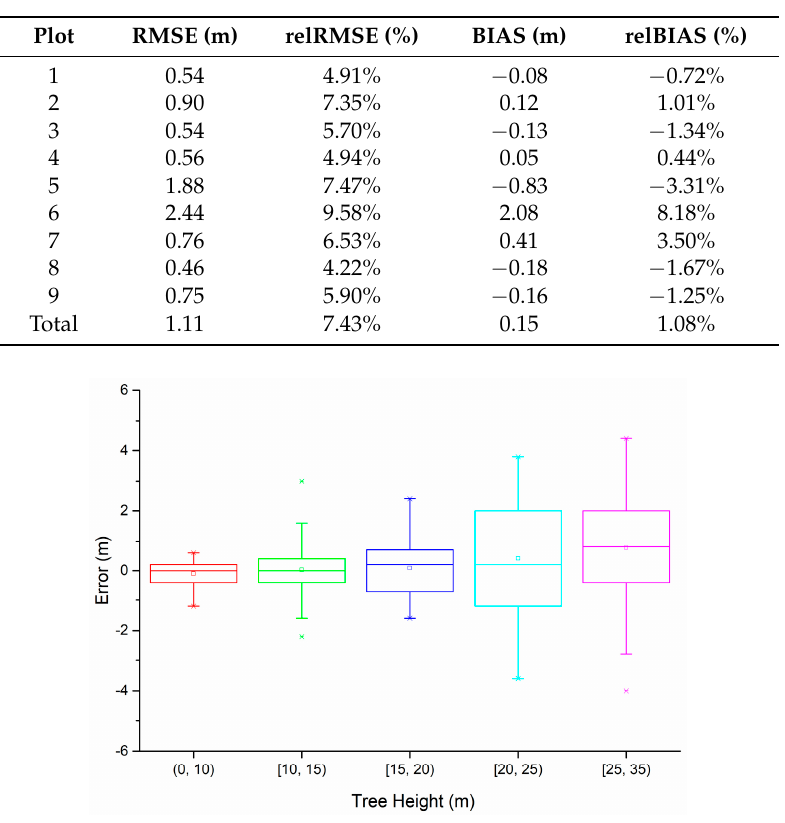
Figure 20. The errors in the tree height observations for different tree heights.